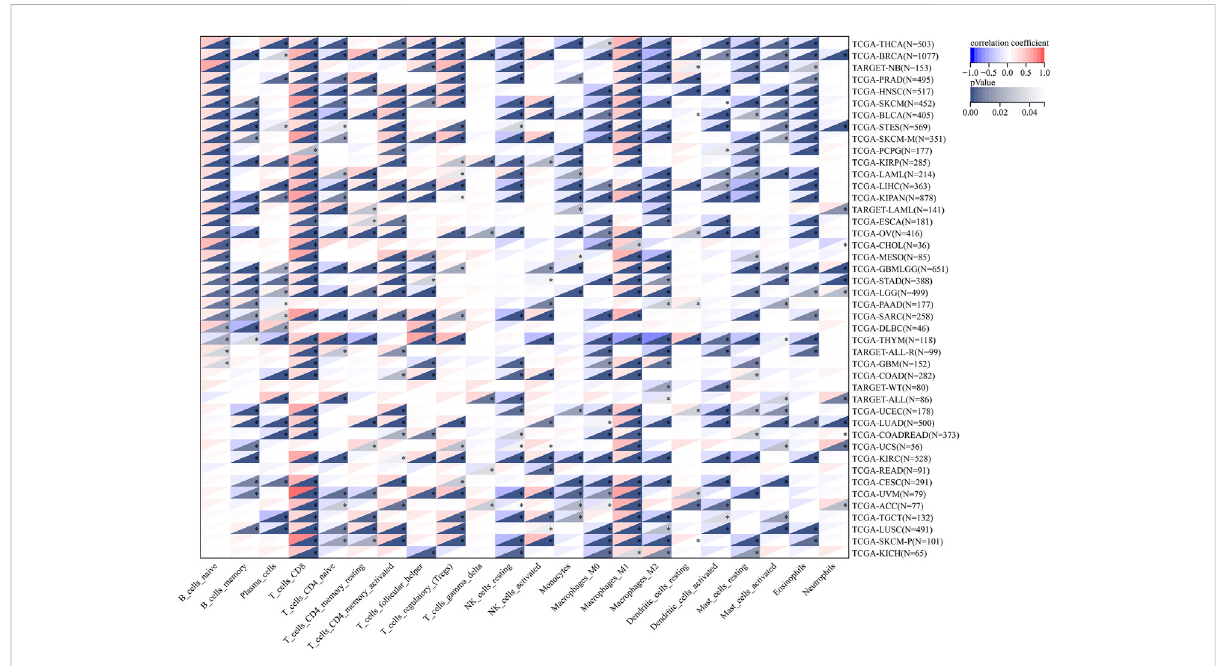
FIGURE 5 Correlation between the expression level of LCK and 22 types of immune cell in fi ltration in 44 types of solid tumors. The original gene expression pro fi le data were derived from TCGA and GTEx